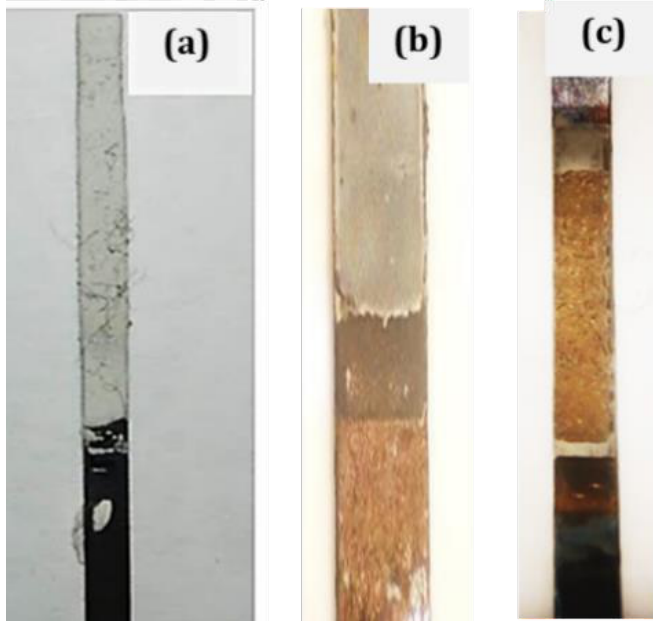
Figure 12. Comparison of multilayers after SPS using different natures of protective layers. ( a ) Samples after SPS for both SrCO 3 and BaCO 3 . ( b ) Sample with SrCO 3 after chemical attack with H 3 PO 4 showing the appearance of surface contamination (whitening on the top Au electrode). ( c ) Sample with a BaCO 3 protective layer after chemical removal.